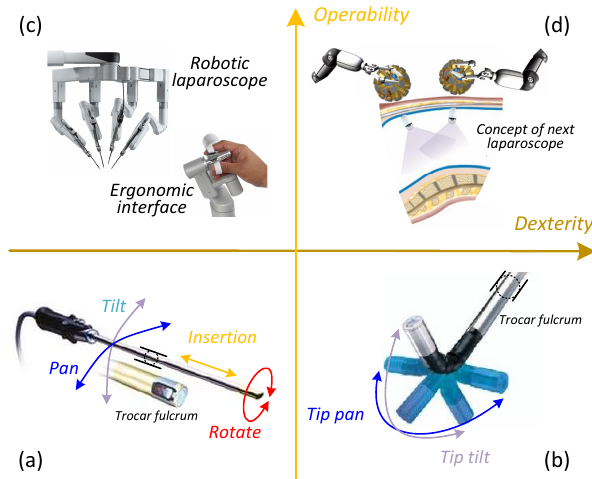
Figure 1. Laparoscope paradigm evolution in terms of operability and dexterity. ( a ) Traditional laparo- scope confined by trocar, ( b ) Laparoscope with an articulating tip, ( c ) Robotic-assisted laparoscope, ( d ) Future laparoscope with dexterous mobility and intuitive